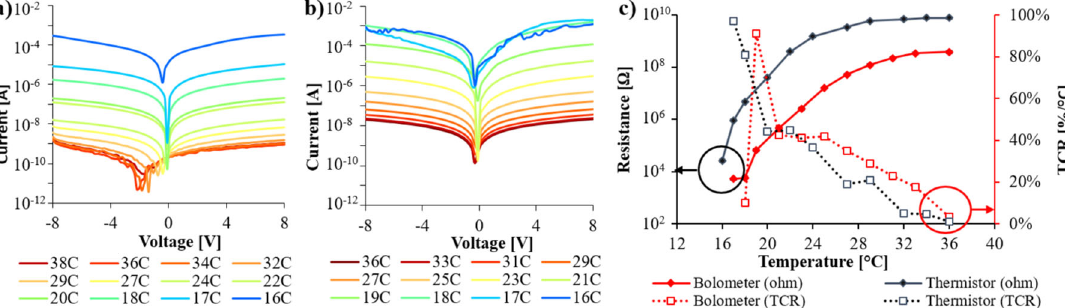
Fig. 3 Temperature-dependent characteristics of the printed thermistor and bolometer devices. a Temperature-dependent I – V characteristics of the P = 50 µm thermistor. b Temperature-dependent I – V characteristics of the P = 50 µm bolometer. c Temperature- dependent resistance and TCR values of the P = 50 µm thermistor and bolometer devices. (error bars representing standard deviation in resistance measurements are present but too small to clearly